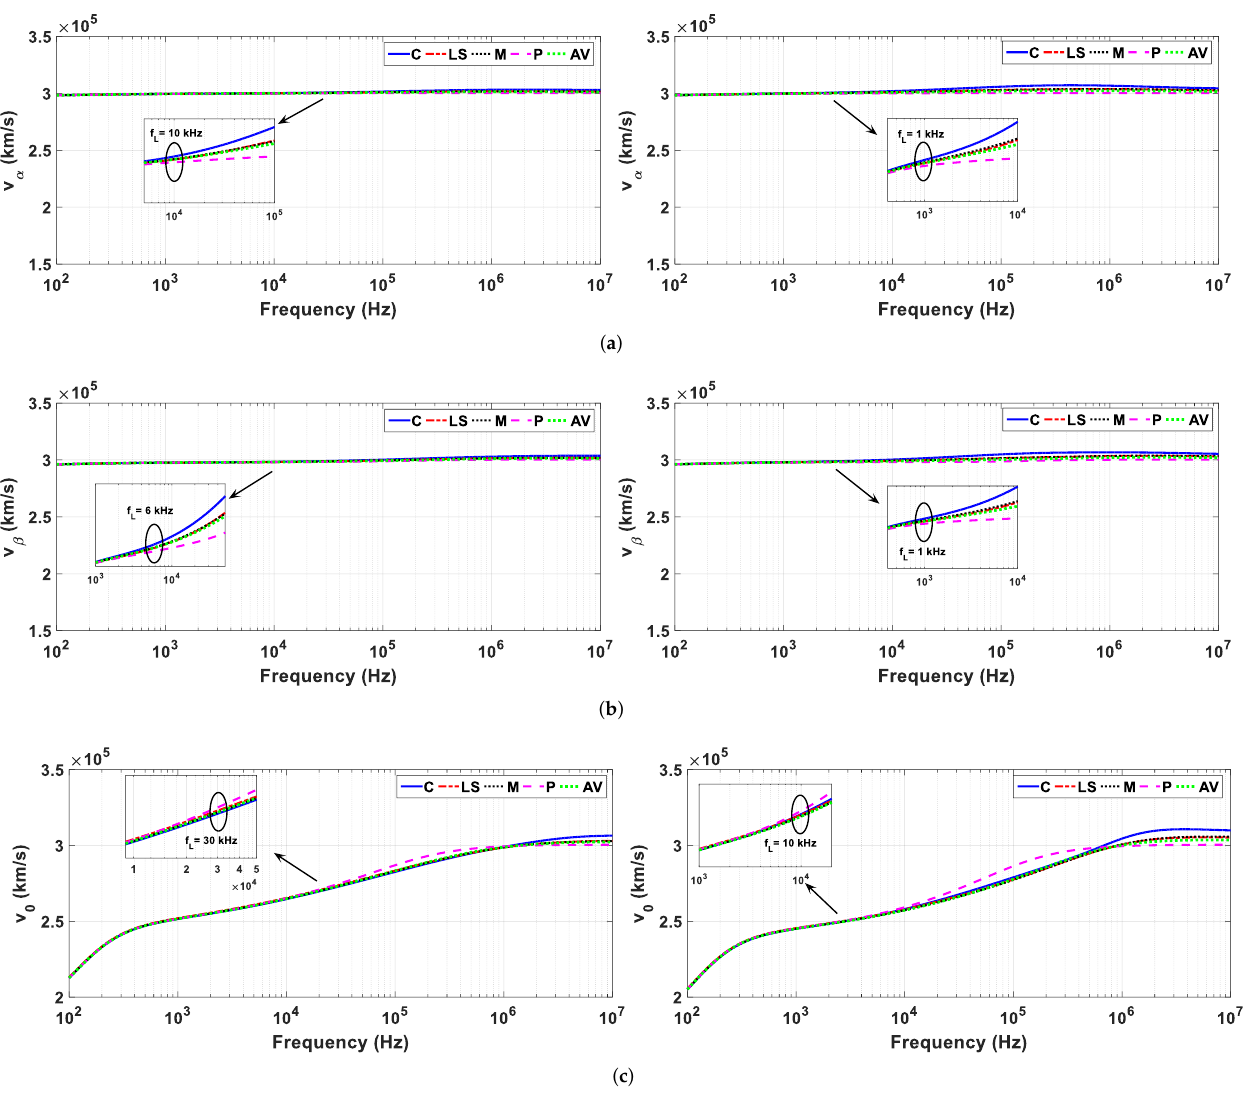
Figure 12. Phase velocity for a soil of 700 Ω · m ( left ) and 4000 Ω · m ( right ): ( a ) mode α ; ( b ) mode β and ( c ) mode